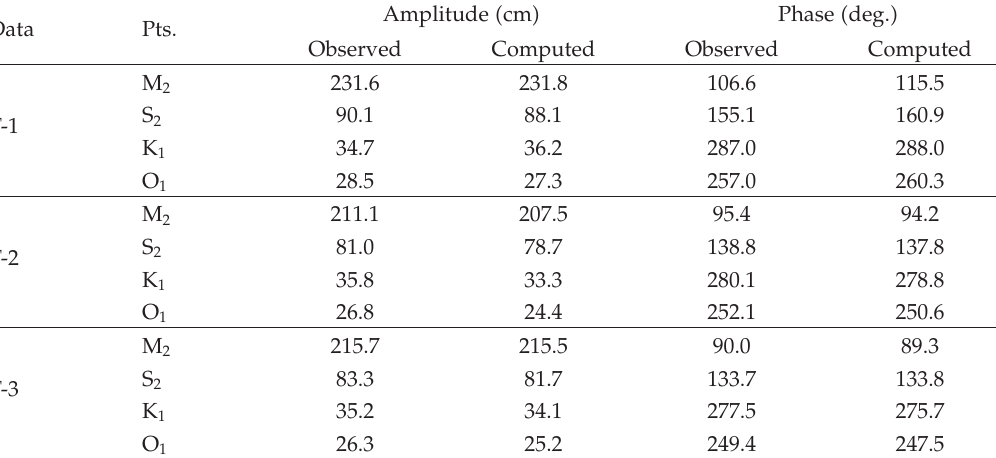
Table 1: Observed data and computed results using harmonic analysis.